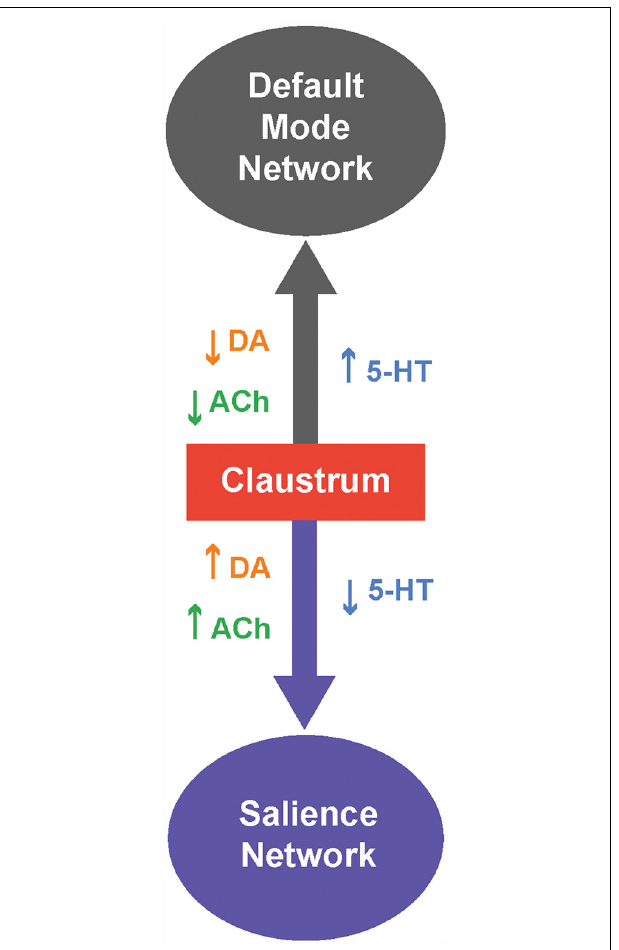
FIGURE 3 | Neuromodulatory control of the claustrum and intrinsic connectivity networks (ICNs). The claustrum serves as a switch between two ICNs: The default mode network (DMN) and salience network (SAN). When 5-HT levels are high, and levels of DA and/or ACh are low, the claustrum is likely inhibited and this favors activation of the DMN. Conversely, when 5-HT levels are low, and levels of DA and/or ACh are high, the claustrum permits activation of the